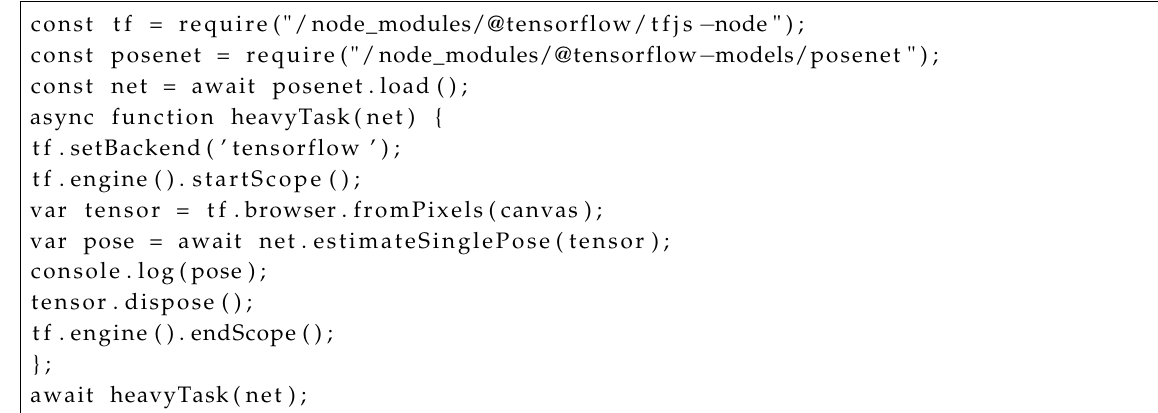
Figure 6. The architecture of distributed processing with multiple servers in the proposed method. Listing 1: Example of extracting feature data and disposing memory with